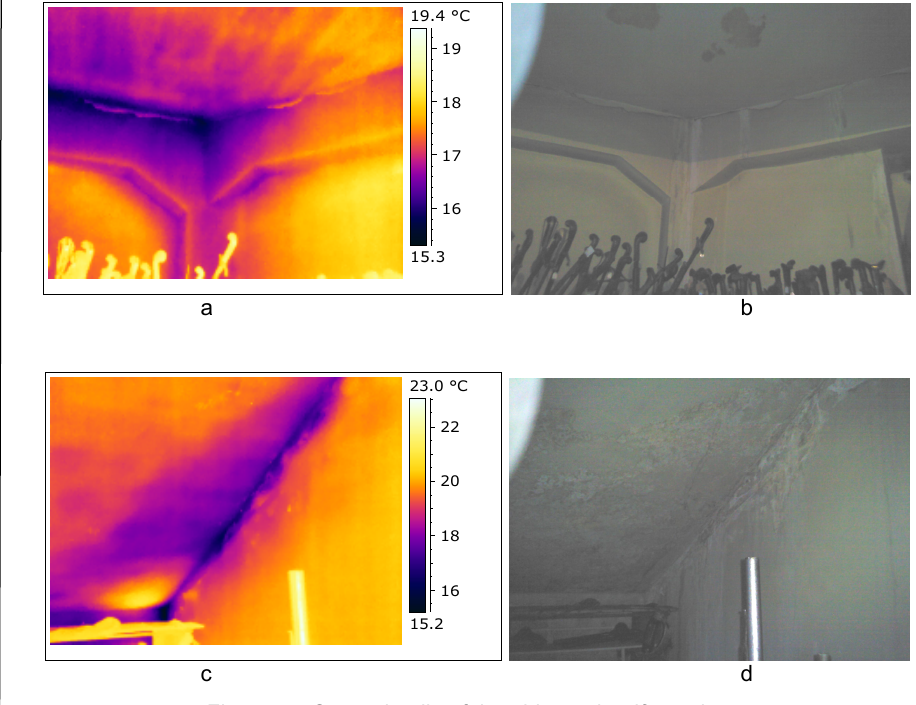
Figure 5 – Some details of the old metal artifacts